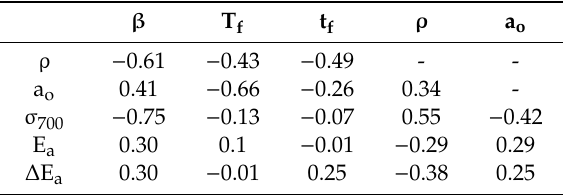
Table 2. Correlation matrix between firing conditions and properties (density, lattice parameter of the cubic phase, electrical conductivity at 700 ◦ C and activation energy) to screen the impact of heating cooling rate, firing temperature and firing time.